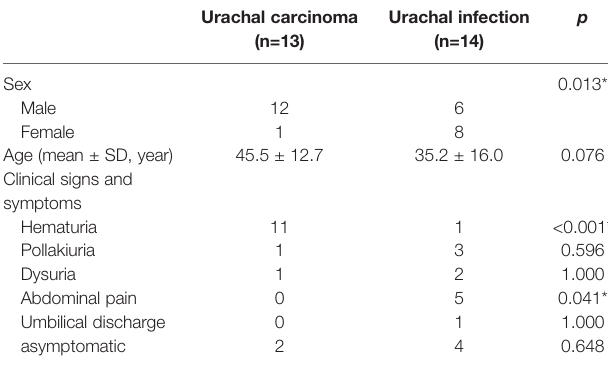
TABLE 2 | Comparison of clinical characteristics of urachal carcinoma and infection patients.